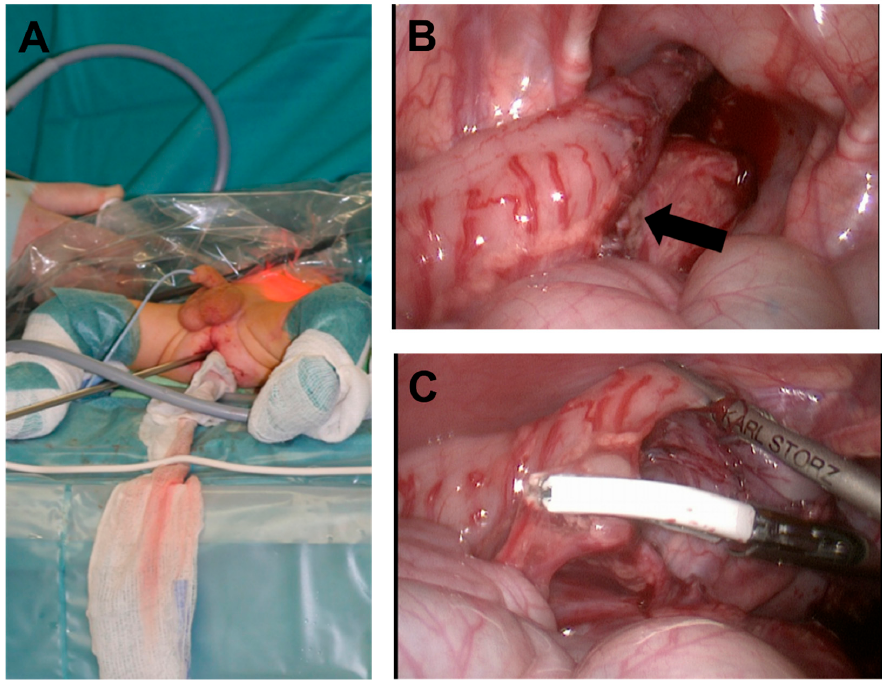
Figure 3. An umbilical camera port is placed, and full-thickness dissection is continued by transanal instrumentation entering the transition zone ( A ). The preoperative abdominal X-ray shows the tran- sition zone (arrow) at the left colonic flexure ( B ).